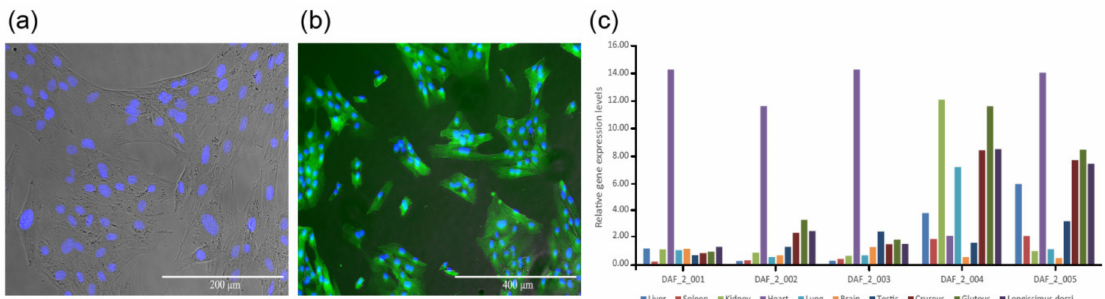
Figure 1. Fat-1 transgenic positive cell line and detection of Fat-1 gene expression levels by q-PCR. ( a ) Merged picture of Fat-1 transgenic cells under an optical microscope and a fluorescent microscope, stained with Hoechst 33342 to show the nucleus. ( b ) Merged picture of Fat-1 transgenic positive cells under a fluorescent microscope with strong EGFP fluorescence ( c ) The gene expression levels of exogenous Fat-1 in di ff erent tissues of Fat-1 transgenic fetuses. The expression level of Fat-1 in DAF_2_001 liver tissue was considered to be